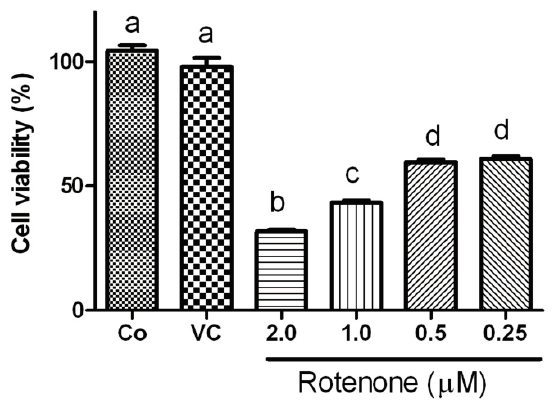
Figure 1. Cell viability after rotenone exposure assayed by alamar blue. Rotenone, at concentrations of 2.0, 1.0, 0.5 or 0.25 µM, induced significant reduction of cell viability compared to control. Data were collected from 3 independent experiments and presented